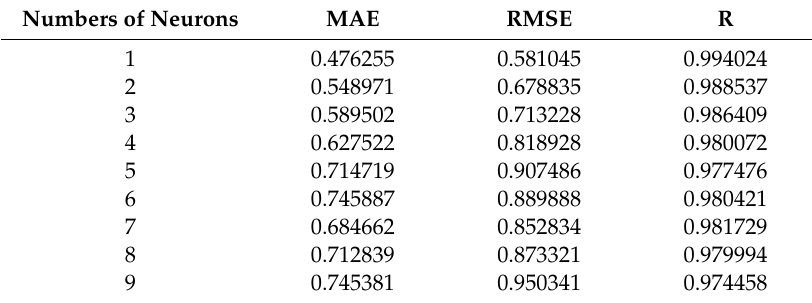
Table 4. Scores of model evaluation indexes with a single hidden layer at di ff erent numbers of